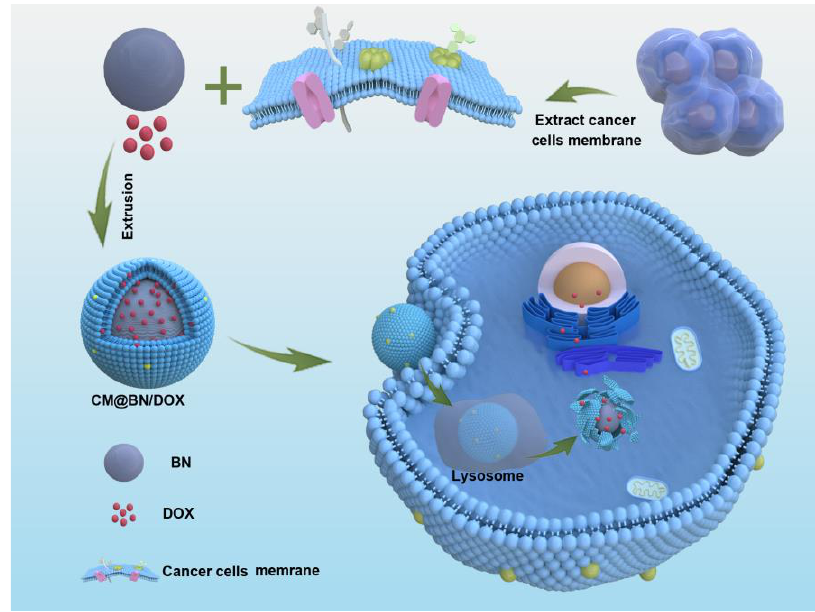
Figure 1. The preparation of CM@BN/DOX complexes.